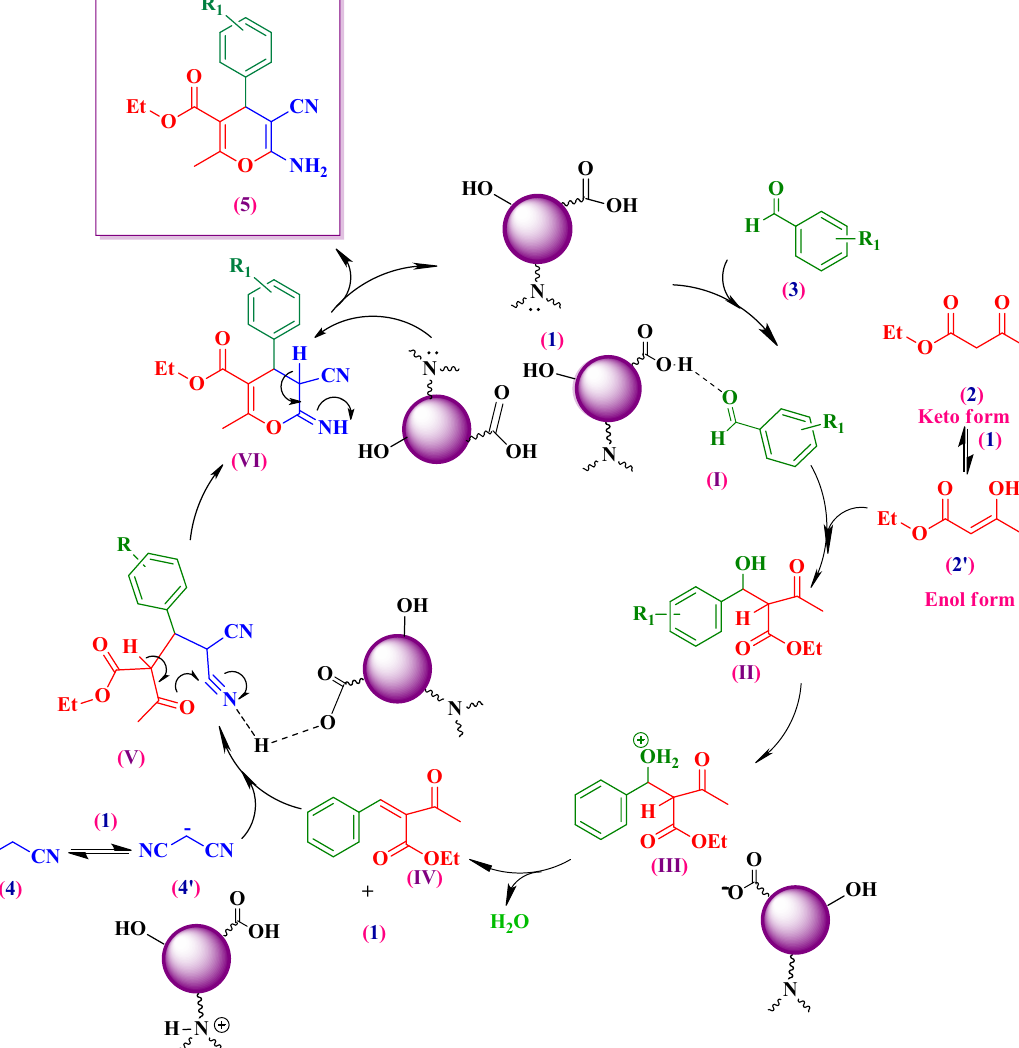
Figure 8. Proposed mechanism for the one-pot synthesis of 5a-l catalyzed by the multifunctional Cs-EDTA- Cell network organocatalyst ( 1 ).